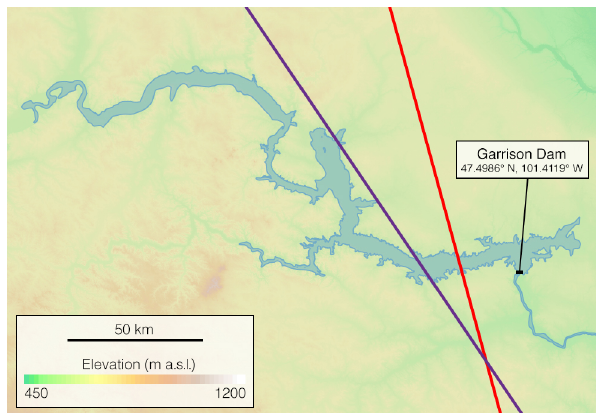
Figure 2. Radar altimeter ground tracks over Lake Sakakawea (blue) overlaid to the SRTM 1arcsec digital terrain model. Purple: 10d resolution instrument series and satellite pass 204; red: 35d resolution series and satellite pass